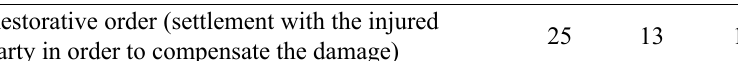
Table 3. Types and number of educational orders in Belgrade from 2015 to 2018 Type of educational order /